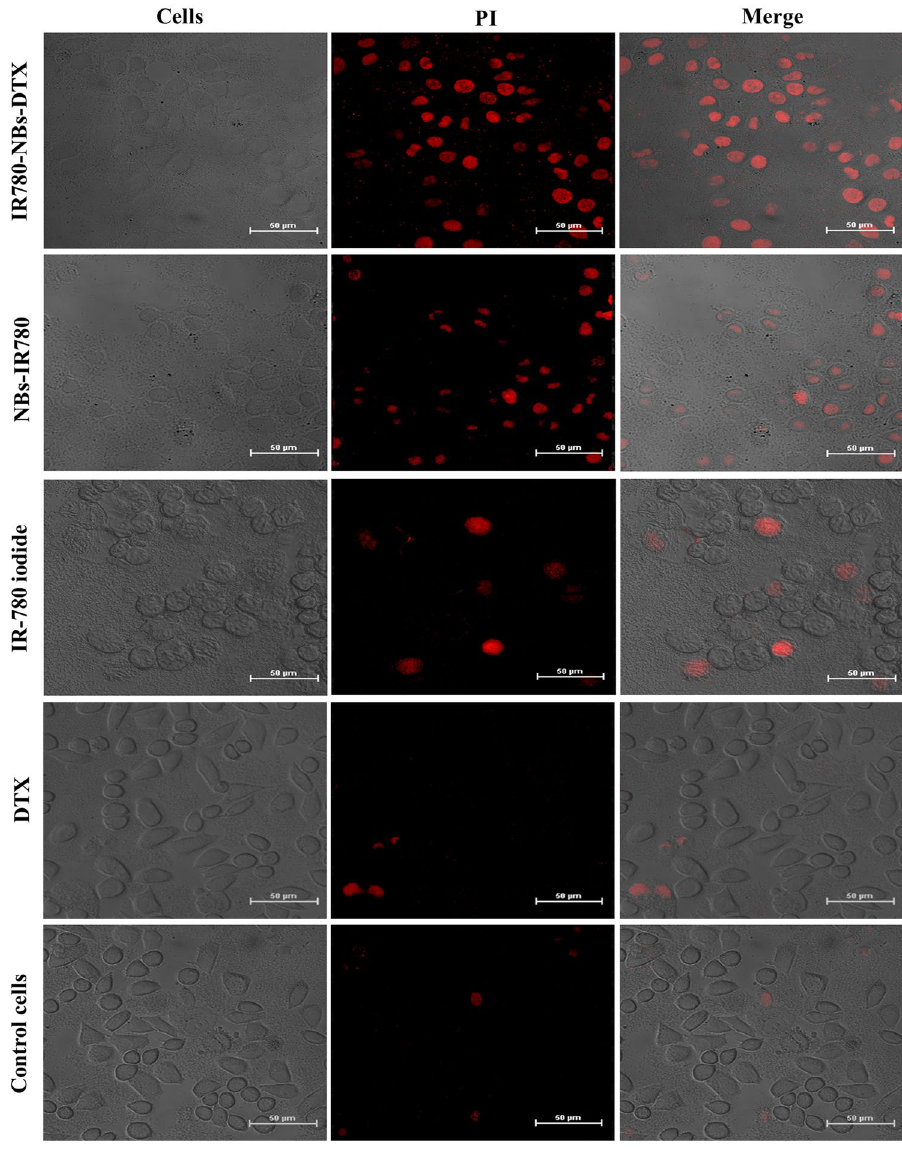
Figure 8. Photothermal ablation combined with chemotherapy with IR780-NBs-DTX, NBs-IR780, IR-780 iodide and DTX assessed via CLSM in Mia-Paca2 pancreatic cancer cells in